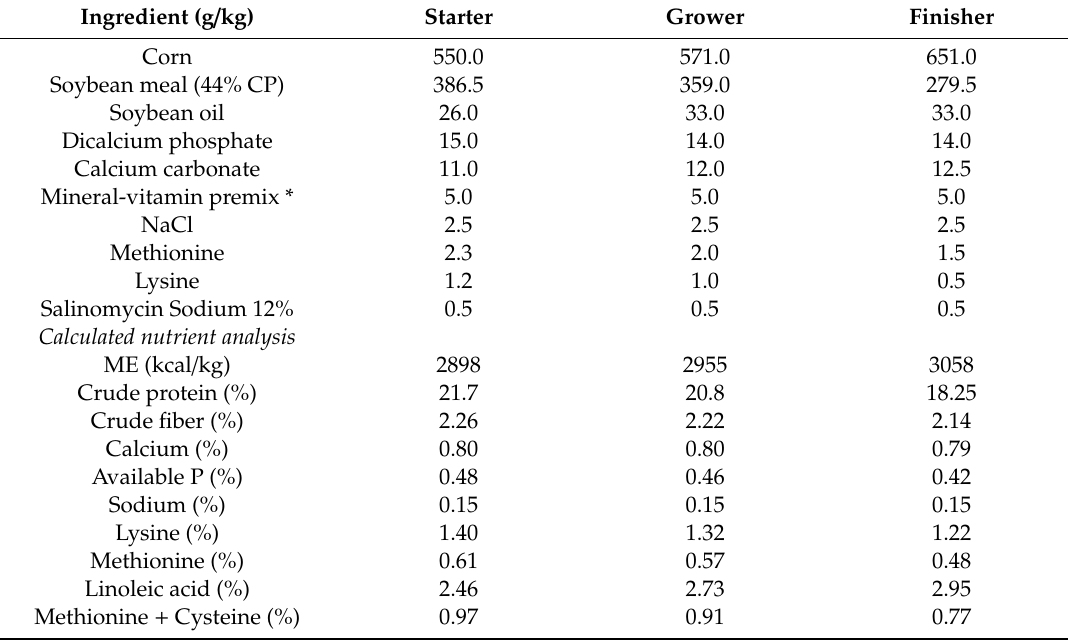
Table 1. Ingredients and nutrient composition of basal diets fed to broiler chickens.